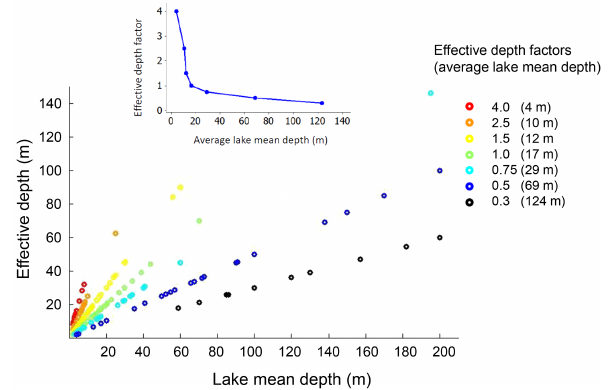
Figure 19. The lake mean depth vs. the modelled effective depth for 244 tuned lakes. Colour coding illustrates the effective depth factors. The average lake depth for each effective depth factor used in the tuning process is also given (insert). This figure demonstrates that deeper lakes are tuned to a shallower effective depth and shal- lower lakes to a deeper effective